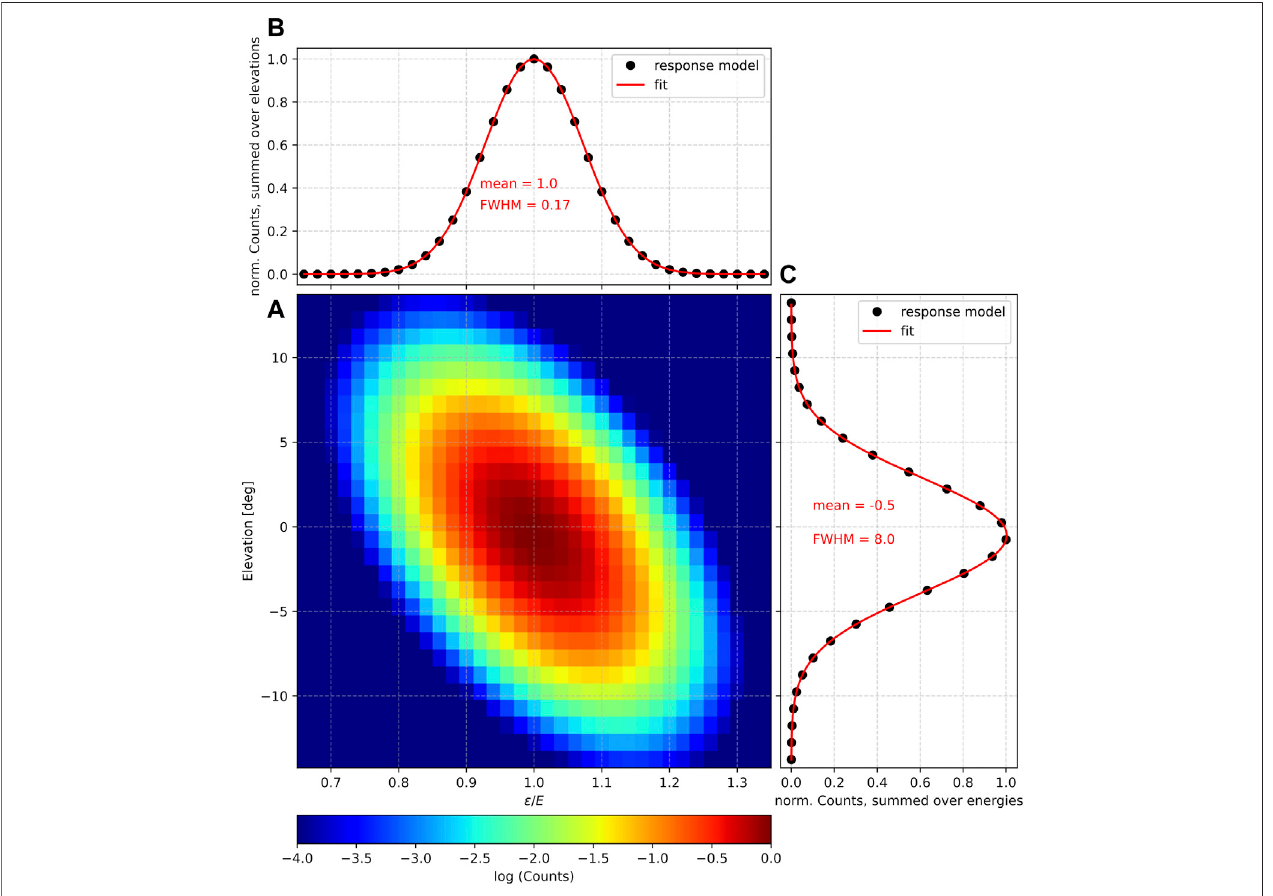
FIGURE 2 | Responsefunctionofourinstrumentmodel. (A) 2Dresponsematrixshowingthelogarithmofthenormalizedparticletransmission,asafunctionoftheparticle elevationdirectionandasafunctiontheparticleenergyovertheenergysetting ( ε / E ) . (B) Theinstrumenttransmission,integratedoverelevationdirections,asafunctionofparticle ε / E and (C) the instrument transmission, integrated over particle ε / E , as a function of the elevation direction. The curves we show are normalized to their maximum value.